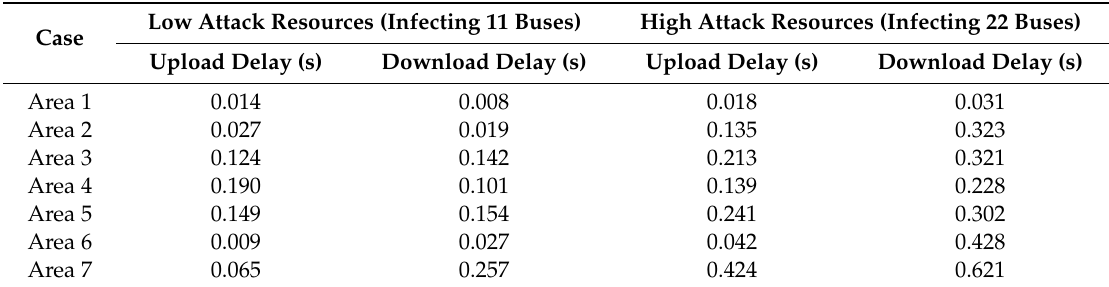
Table 5. Delay results of communication network after DDoS attacks.